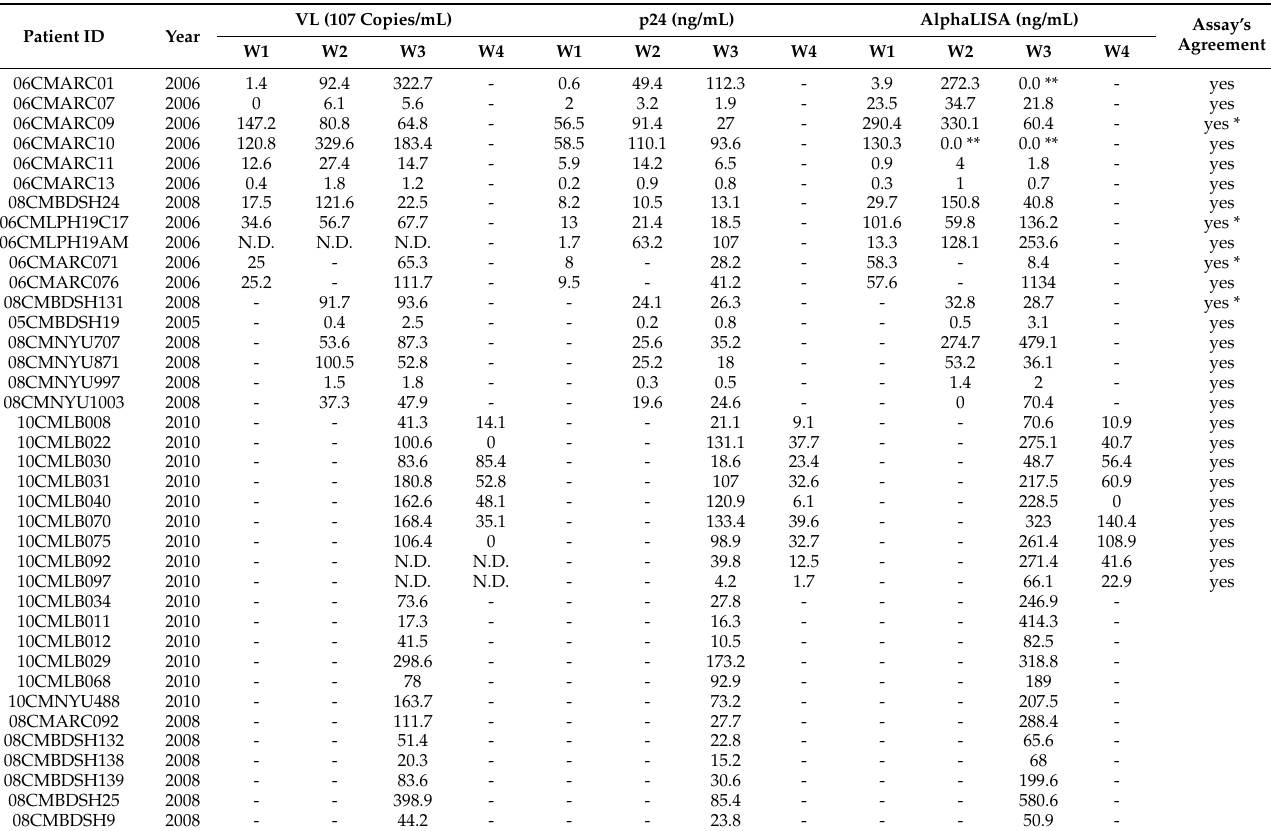
Table 1. Detection of viral load (VL), p24, and AlphaLISA.